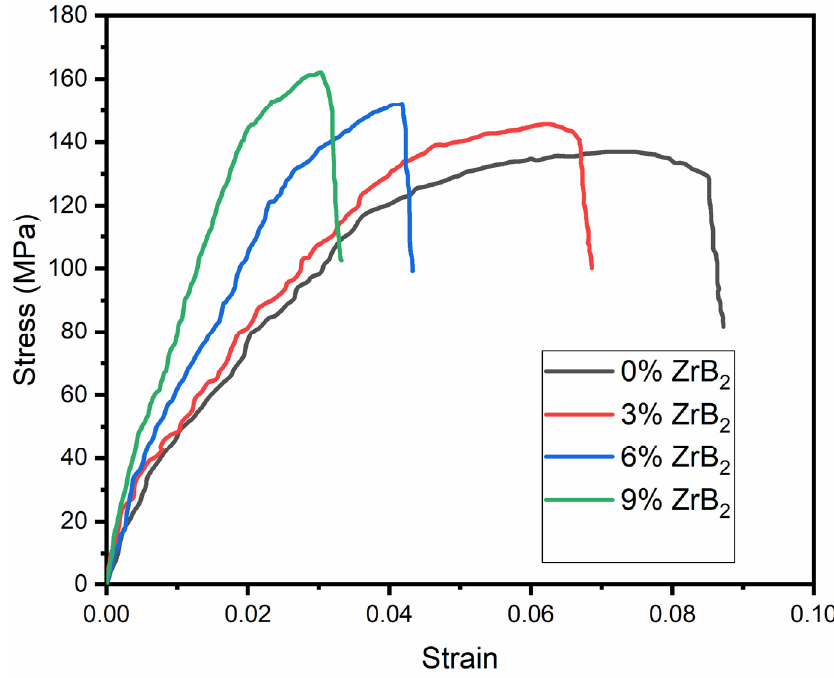
Figure 8. Tensile strength of ADC12 and its composites with ZrB 2 reinforcement. Table 2. Obtained strength for the